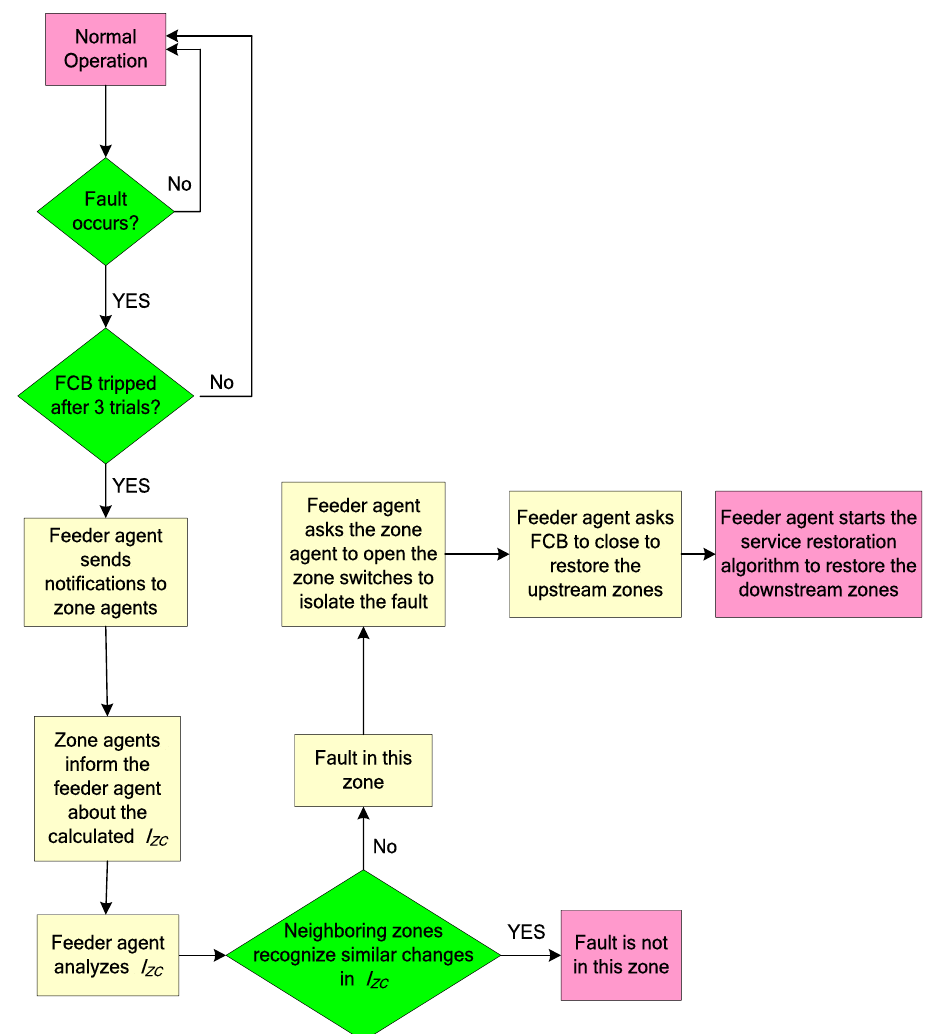
Figure 2. Flowchart of the proposed fault locating and isolation